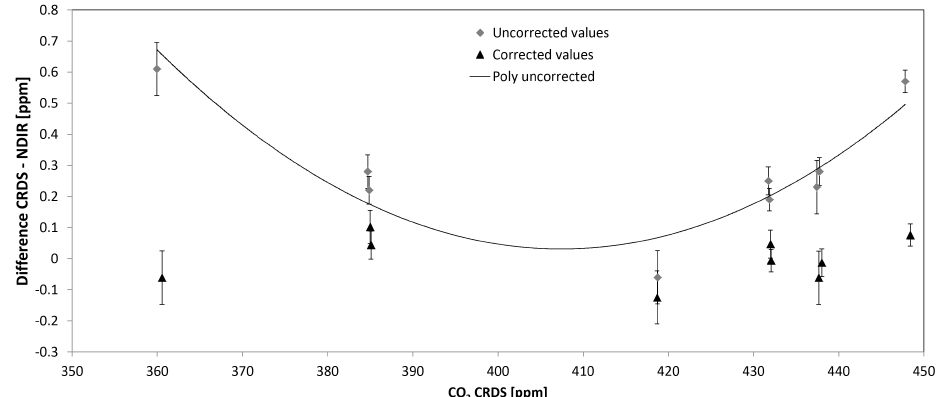
Figure 9. The difference between the Picarro (CRDS) – Maihak (NDIR) CO 2 values as a function of the CRDS values of old KUP calibra- tion cylinders. The data show a polynomial dependency (grey diamonds); by correcting the data points with the according second degree polynomial (black line), the difference between the two systems varies slightly around zero (black triangles). The vertical error bars represent the combined standard deviation of both systems whereas the horizontal error bars represent only the standard deviation of the CRDS system. Because of the scale, the horizontal error bars are not